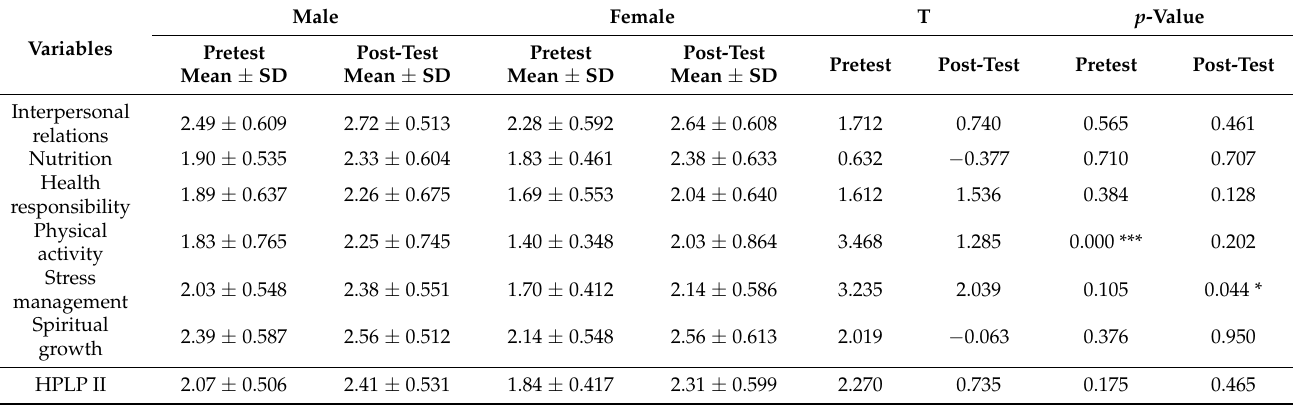
Table 8. Comparison of male and female groups for HPLP